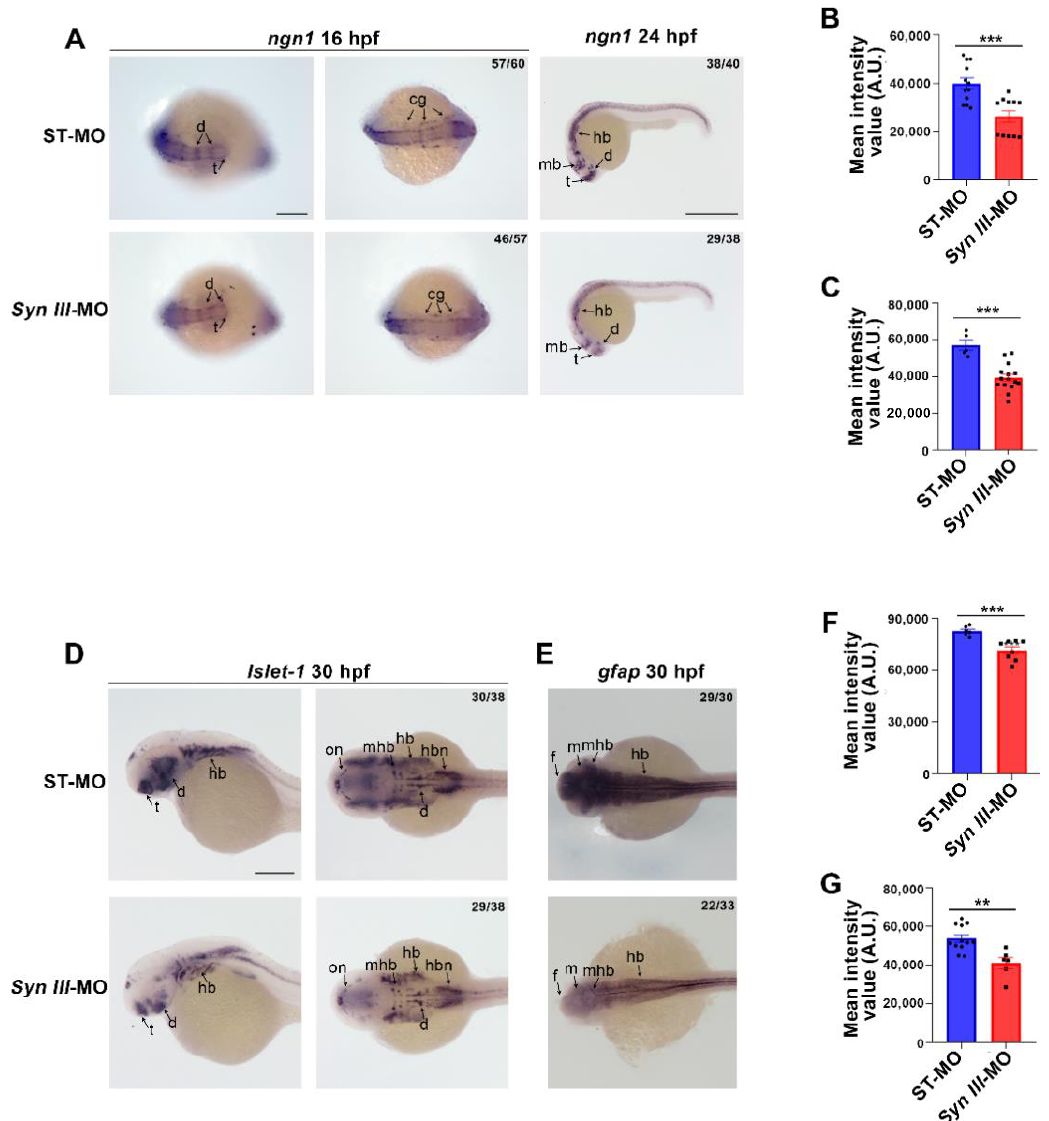
Figure 2. Expression of ngn1 , Islet-1 and gfap is reduced in Syn III- MO injected embryos. ( A ) Representative images of ST-MO and Syn III -MO-injected zebrafish embryos hybridized with ngn1 at 16 hpf and 24 hpf. Abbreviations: mb: midbrain, hb, hindbrain; cg, cranial ganglia; t, telencephalon; d, diencephalon. 16 hpf scale bar, 200 μm; 24 hpf scale bar, 500 μm. ( B , C ) Quantification of ngn1 signal at 16 hpf ( B ) and 24 hpf ( C ) as mean intensity values in arbitrary units (A.U.). Syn III -MO-injected embryos showed a significant decrease in the mean intensity value when compared to control embryos (*** p < 0.001, unpaired Student’s t -test, n = 12 embryos per group). ( D , E ) Representative images showing 30 hpf embryos hybridized with Islet-1 ( D ) and gfap ( E ), scale bar = 200 μm for all the panels. Abbreviations: d, diencephalon; f: forebrain; hb, hindbrain; hbn, hindbrain neurons; mhb, midbrain hindbrain boundary; mb, midbrain; on, optic nerve; t, telencephalon. ( F , G ) Quantification of Islet-1 ( F ) and gfap ( G ) signal expressed as mean intensity values. Syn III -MO-injected embryos exhibited a significant decrease of both Islet-1 (( F ), *** p < 0.001 unpaired Student’s t -test) and gfap when compared to control embryos (( G ), ** p < 0.01, unpaired Student’s t -test). n = 6 – 15 embryos per group).